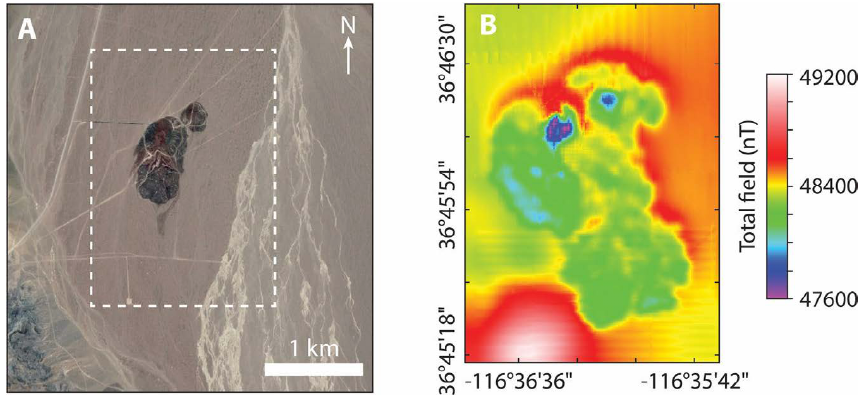
Figure 7: UAS magnetic survey data collected using a DJI Matrice 100 with dual triaxial fluxgate sensors (SENSYS MagDrone R3; Figure 1G). [A] Overview imagery (© 2020 Maxar Technologies, Google Earth) of the survey area (dashed box) of Little Cones, Amargosa Valley, Nevada, USA, illustrating the limited surface exposure of black volcanic rocks. [B] Interpolated magnetic map of preliminary field data prior to correction for UAS vehicle heading. Buried lava is revealed by the irregularly shaped central area of low total magnetic field (mainly green and blues) which result from the reverse polarisation of the volcanic